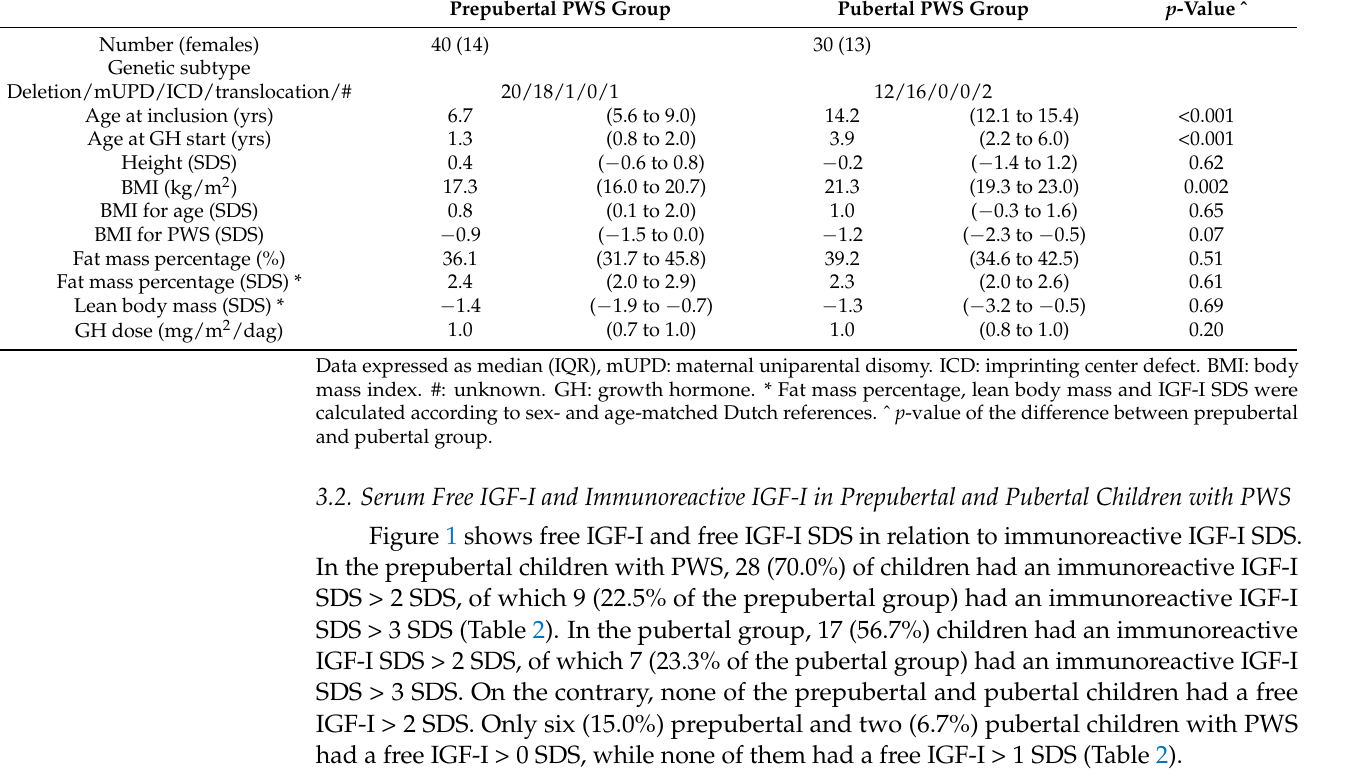
Table 2. Immunoreactive IGF-I, free IGF-I and IGFBP-3 levels in GH-treated children with